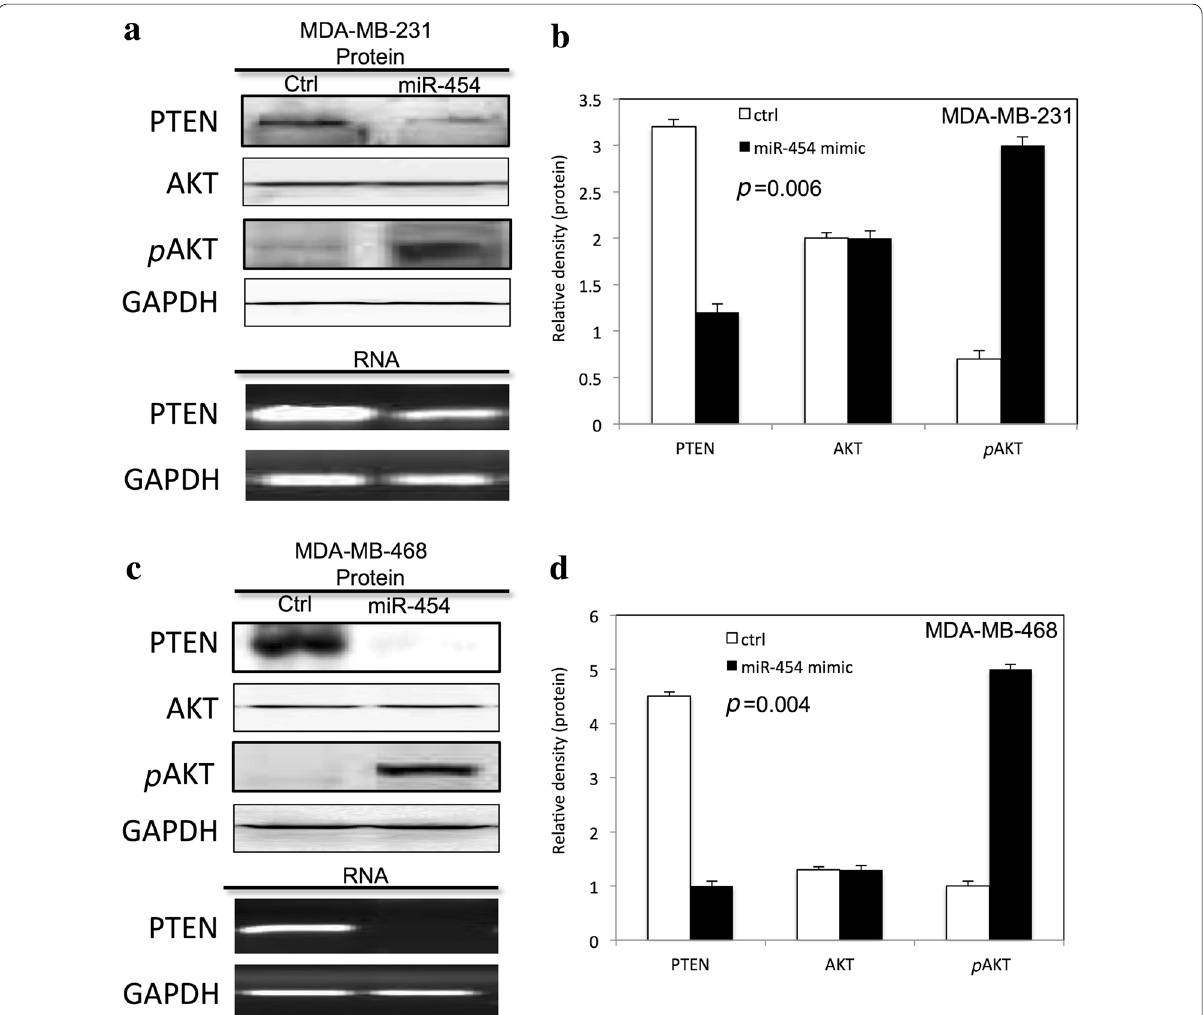
Fig. 6 miR-454 activated pAKT in TNBC cells. a The expression of, pAKT, AKT and PTEN in MDA-MB-231 cells after overexpression of miR-454. b The relative expression level of proteins on MDA-MB-231 cells after overexpression of miR-454 by densitometric analysis. c The expression of pAKT, AKT and PTEN in MDA-MB-468 cells after overexpression of miR-454. d The relative expression level of proteins on MDA-MB-468 cells after overexpres- sion of miR-454 by densitometric analysis. All experiments were performed in